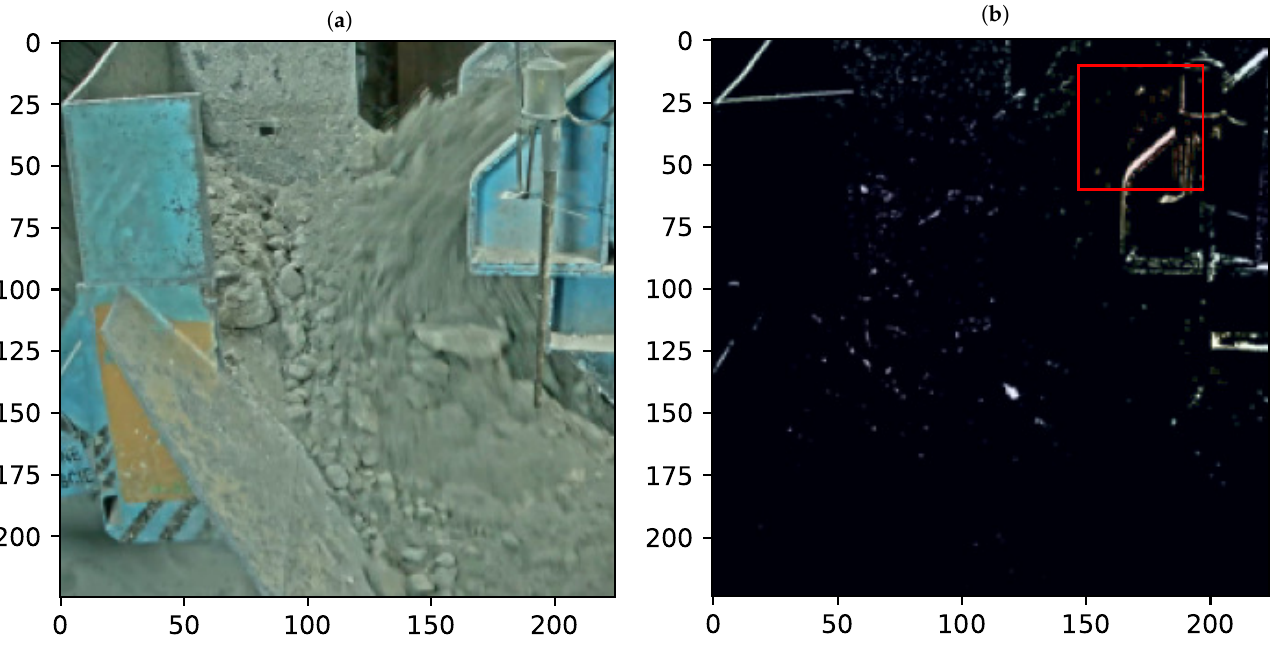
Figure 14. The result of the autoencoder network operation: ( a ) original image of blockage—foreign body mining anchor; ( b ) location of the anomaly most clearly.